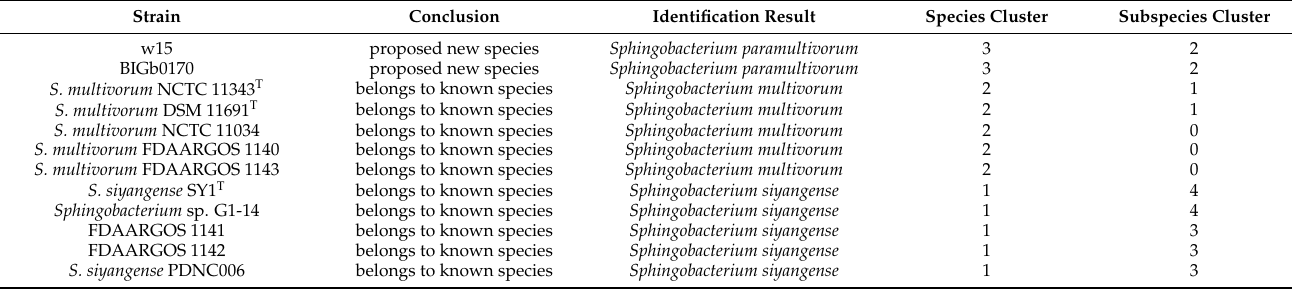
Figure 4. Heat map of dDDH analyses of strain w15, BIGb0170, S. multivorum NCTC 11343 T , S. siyangense SY1 T and closely related species. Table 5. Taxonomic identification based on whole genome sequences.